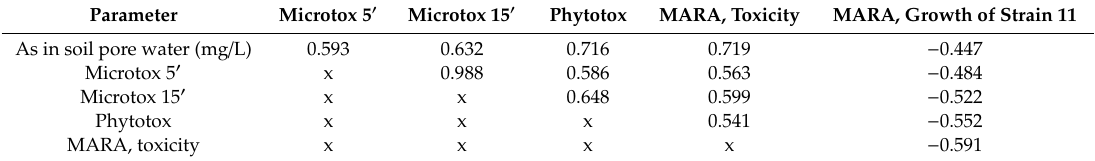
Table 2. Pearson correlation coe ffi cients illustrating the relationships between As concentrations in soil pore water and the results of ecotoxicity assays. MARA, the Microbial Assay for Risk Assessment. Parameter Microtox 5 (cid:48) Microtox 15 (cid:48) Phytotox MARA, Toxicity MARA, Growth of Strain 11 As in soil pore water (mg / L) 0.593 0.632 0.716 0.719 − 0.447 Microtox 5 (cid:48) x 0.988 0.586 0.563 − 0.484 Microtox 15 (cid:48) x x 0.648 0.599 − 0.522 Phytotox x x x 0.541 − 0.552 MARA, toxicity x x x x −